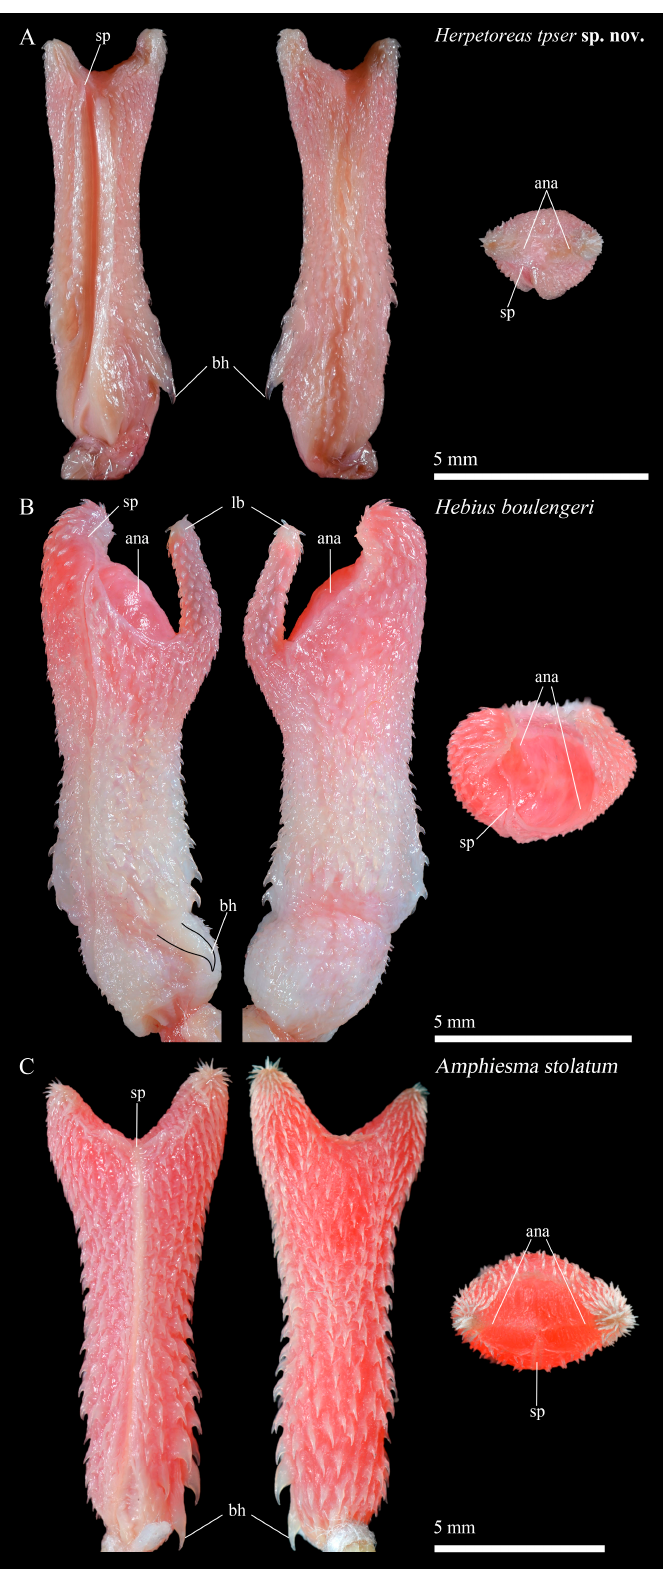
Figure 11. Sulcate, asulcate, and apical sides of the hemipenis distinguishing different genera of Amphiesma sensu lato . ( A ) Amphiesma stolatum , SYS r001727; ( B ) Hebius boulengeri , SYS r001680; ( C ) Herpetoreas tpser sp. nov. , CIB 107855. Photographs by Jun-Jie Huang ( A , C ) and Jin-Long Ren ( B ). Legend —— sp: sulcus spermaticus ; bh: basal hook; ana: apical naked area; lb: left lobe of hemipenis.